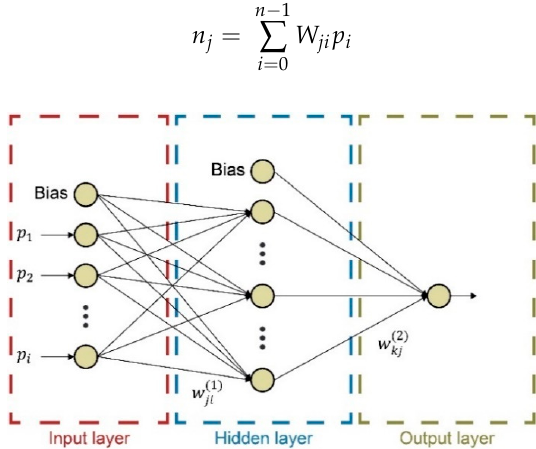
Figure 4. Example of an MLP of a hidden layer.